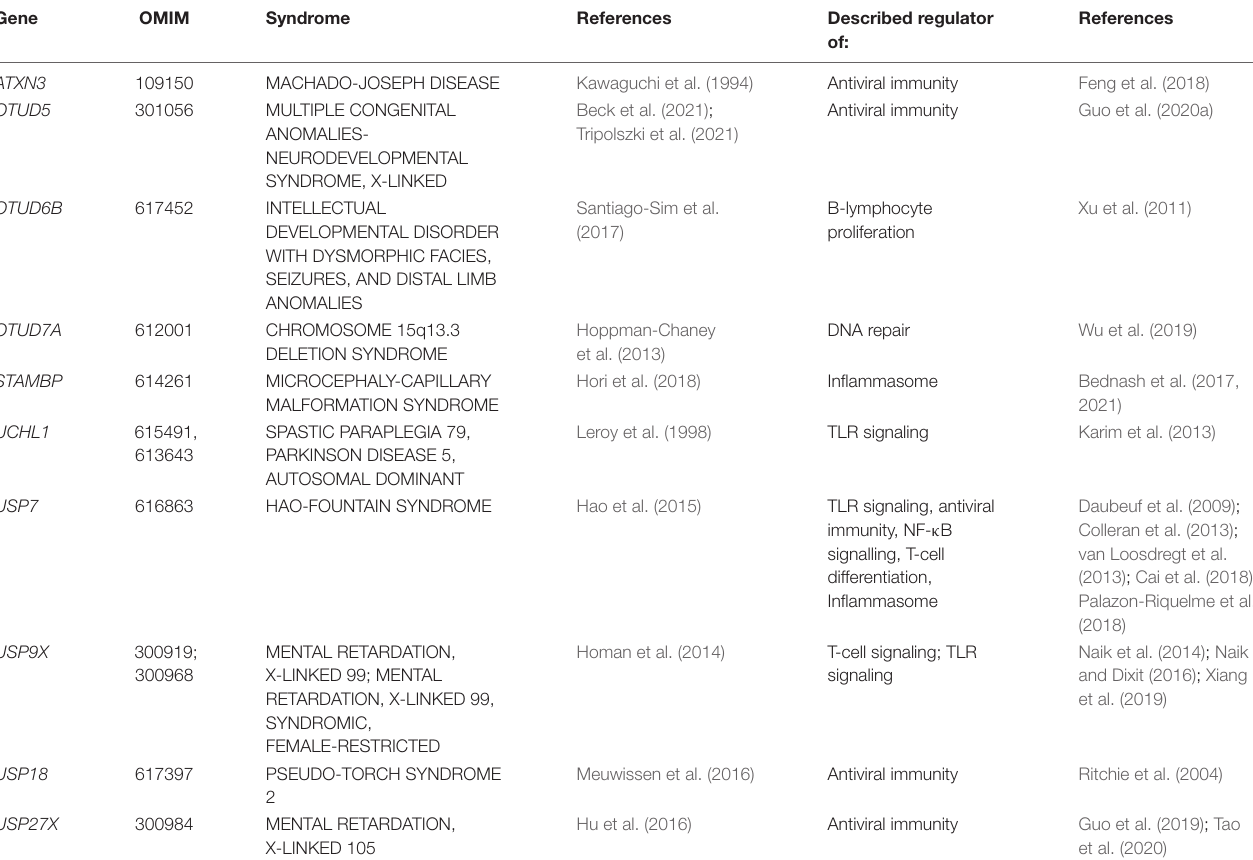
TABLE 3 | NDD-causing genes encoding DUB and associated